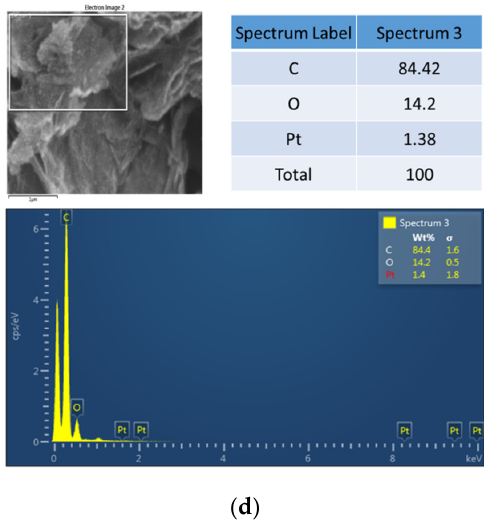
Figure 4. SEM images of 9 s APPJ-sintered ( a ) reduced graphene oxides (rGOs) (without adding H 2 PtCl 6 solution in the pastes); ( b ) Pt-decorated rGOs (with 50 µ L H 2 PtCl 6 solution in the pastes); ( c ) Magnified image of the squared region shown in (b); ( d ) EDS spectrum.